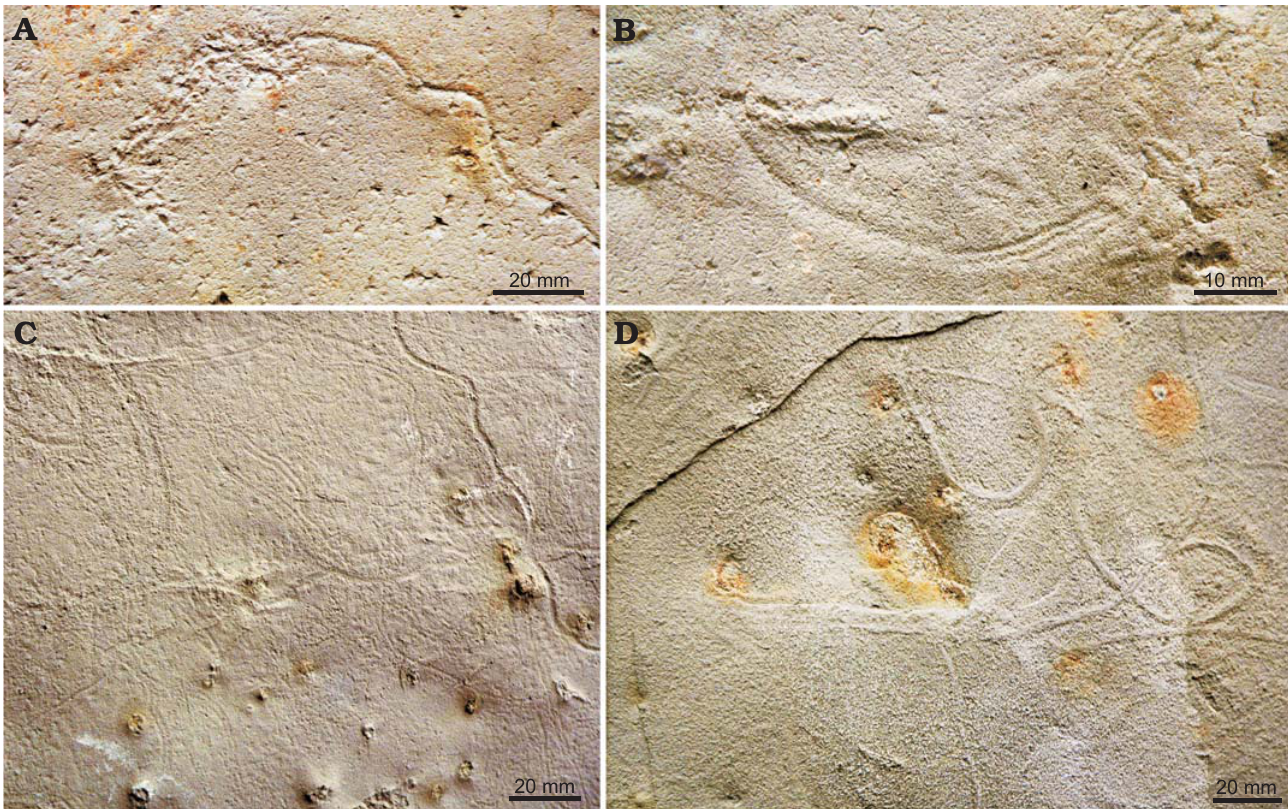
Fig. 7. Arthropod trace fossil Glaciichnium australis isp. nov. preserved mostly as unilobated or bilobated median trails, middle–late Eocene, Mount Wawel Formation, King George Island, Antarctica, slab ZPAL Tf.8/2007.25. A . Unilobate median trail passes into irregular trackway, produced proba- bly in low cohesive substrate. B . A transition between unilobate and bilobate median trail. C . Unilobate and bilobate median trails as epichnial furrows. D . Hypichnial ridges, which are unilobated median trails resembling the trace fossil Helminthoidichnites